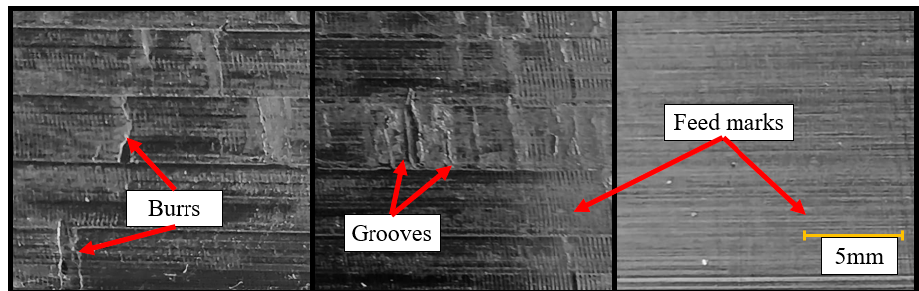
Figure 12. Macro dents on machined surfaces obtained with up ‐ milling.